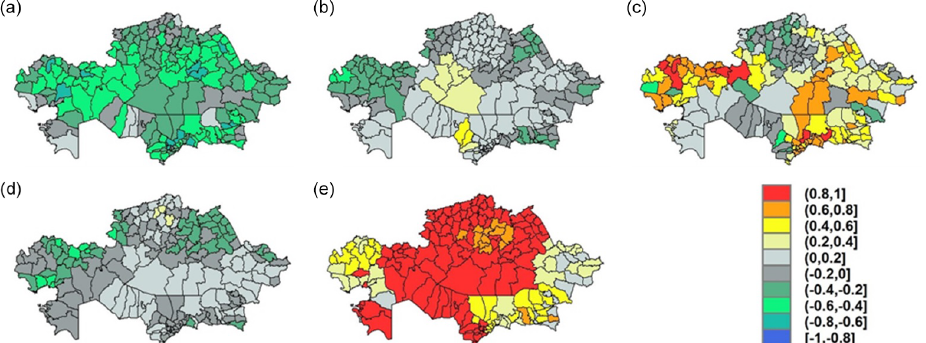
Figure 5. Pairwise robust rank correlations of year with (a) fraction of burned area, (b) PDSI, (c) proportion of grassland layer, (d) ANPP and (e) livestock density without considering their interactions.